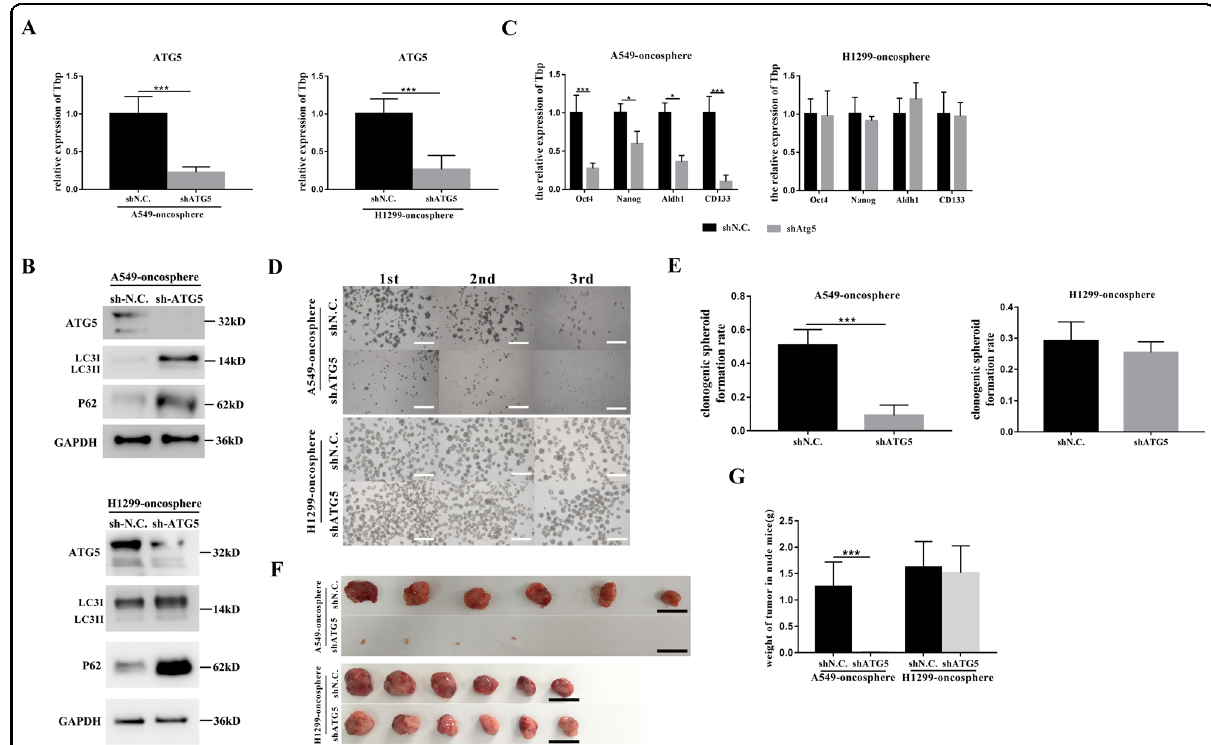
Fig. 3 The stemness of A549-oncosphere, and not that of the H1299-oncosphere, is inhibited upon ATG5 silencing. A Analysis of ATG5 mRNA expression ( A Tbp was used as a reference control. *** p < 0.01.) and protein expression ( B GAPDH was used as a reference control) in A549- oncosphere and H1299-oncosphere, shN.C. was the negative control. C Analysis of mRNA expression of stem cell markers Oct4, Nanog, Aldh1, and CD133 upon ATG5 silencing in A549-oncosphere and H1299-oncosphere cells; Tbp was used as a reference control. * p < 0.05, *** p < 0.01. Colony formation assay ( D bar = 120 µm) and single-cell cloning assay, 1st means single-cell suspensions were plated at 1000 cells/well, 2nd means spheroid cultures were then collected from 1st and single-cell suspensions were prepared for setting up the second round of the assay at 1000 cells/well, and so forth. The 3rd means 1000 cells came from the 2nd ( E *** p < 0.01.) using A549-oncosphere and H1299-oncosphere in which ATG5 was silenced. F , G Subcutaneous tumors excised ( F images; G tumor weight, ***:*** p < 0.01: p < 0.01) from nude mice receiving A549-oncosphere-shATG5, H1299- oncosphere-shN.C. and H1299-oncosphere-shATG5 cells. Bar = 1